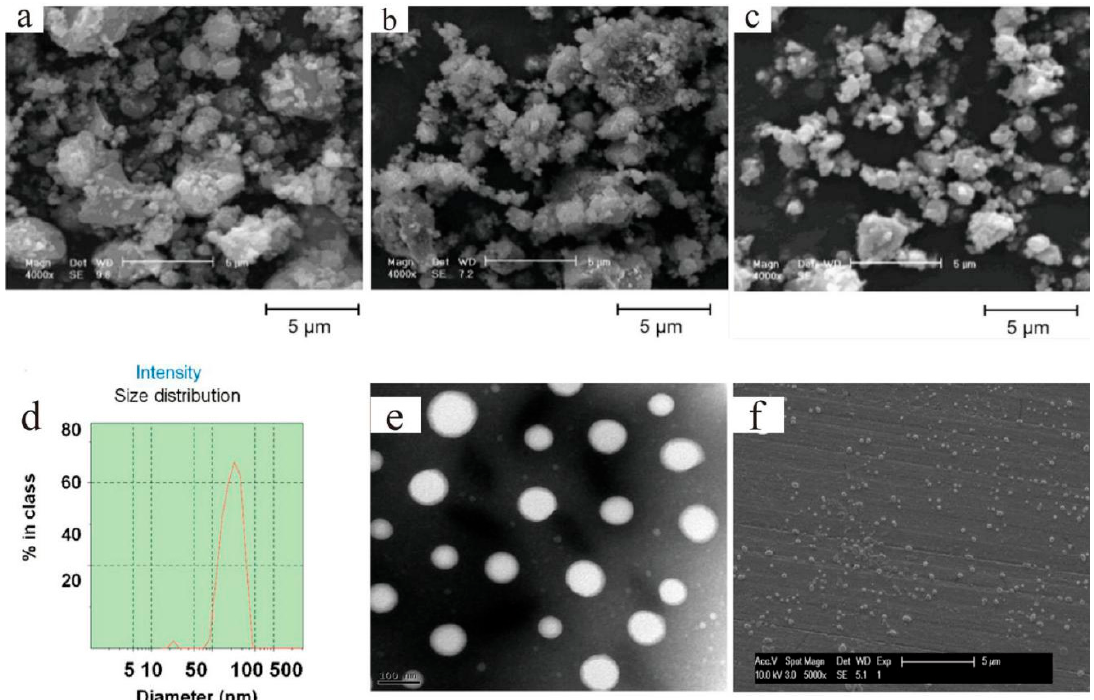
Figure 5. Morphology of powder particles (stoichiometric composition) after ( a ) 90 min, ( b ) 120 min, and ( c ) 240 min of milling times [39] Reproduced with permission from [A. Heidarpour et al.], [Journal of Alloys and Compounds]; published by [Elsevier], 2009; characterization of the gel nanocarriers (NCs). ( d ) Particle size and size distribution, ( e ) TEM and ( f ) SEM images of the gel NCs [40]. Reproduced with permission from [Wei He et al.], [International Journal of Pharmaceutics]; published by [Elsevier], 2015.